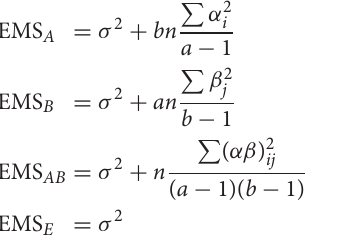
TABLE 2 | The numerator and denominator mean squares from Equation (2) used to form appropriate F -tests for the model in Equation